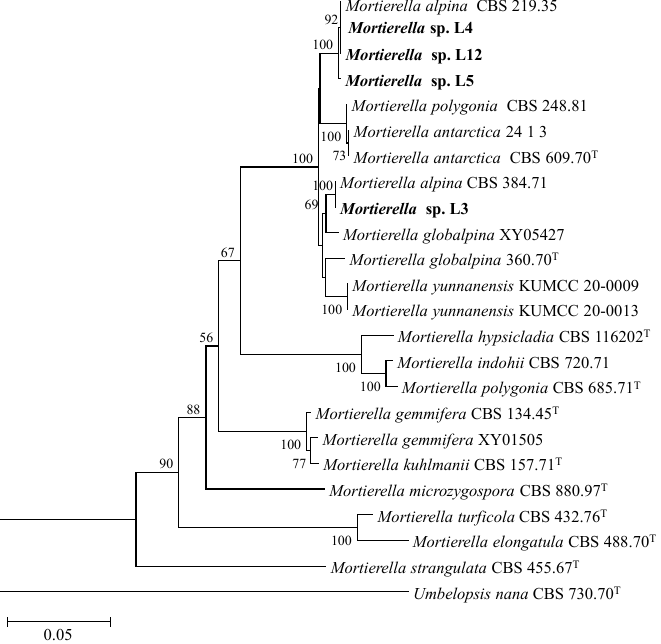
Figure 1. Neighbor-joining phylogenetic analysis based on the combined sequences of internal transcribed spacer (ITS) and large subunit (LSU) regions of the four fungal isolates. The phylogenetic tree was constructed using the MEGA 6 program. The supported values from the 1000 bootstrap copies are illustrated under their respective branches. The sequences obtained in this study are marked in bold. Table 1. Strains used in the molecular phylogenetic analysis in this study.